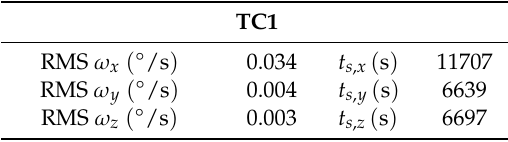
Table 4. Root Mean Square of the angular rates estimation error and settling times for Test Case 1.